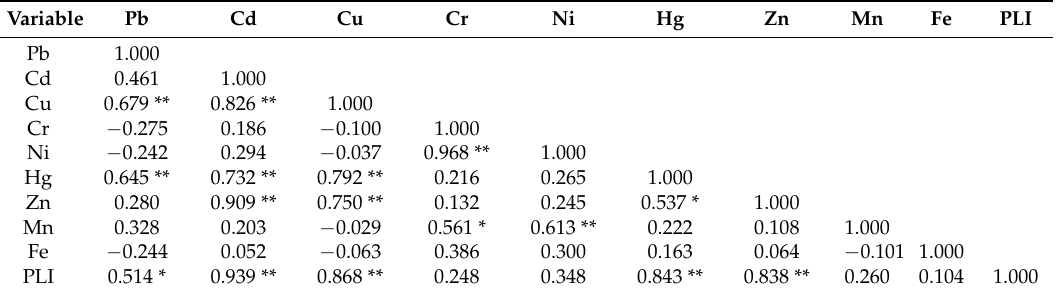
Table 7. Correlation matrix of heavy metals in the sediment samples for the LPS (Spearman correlation- rs